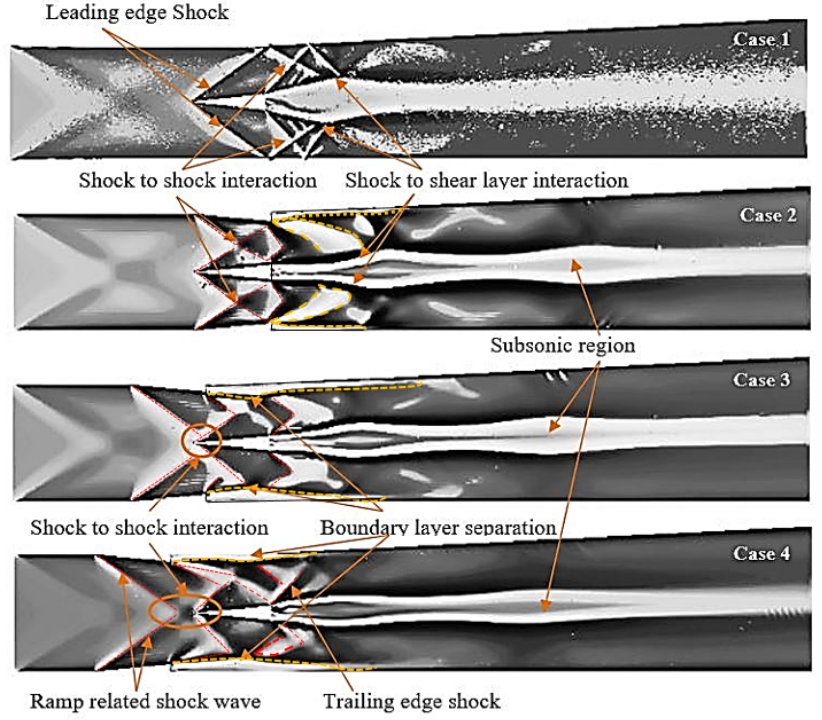
Figure 6. Numerical shadowgraph of strut-based scramjet combustor with different ramp location.